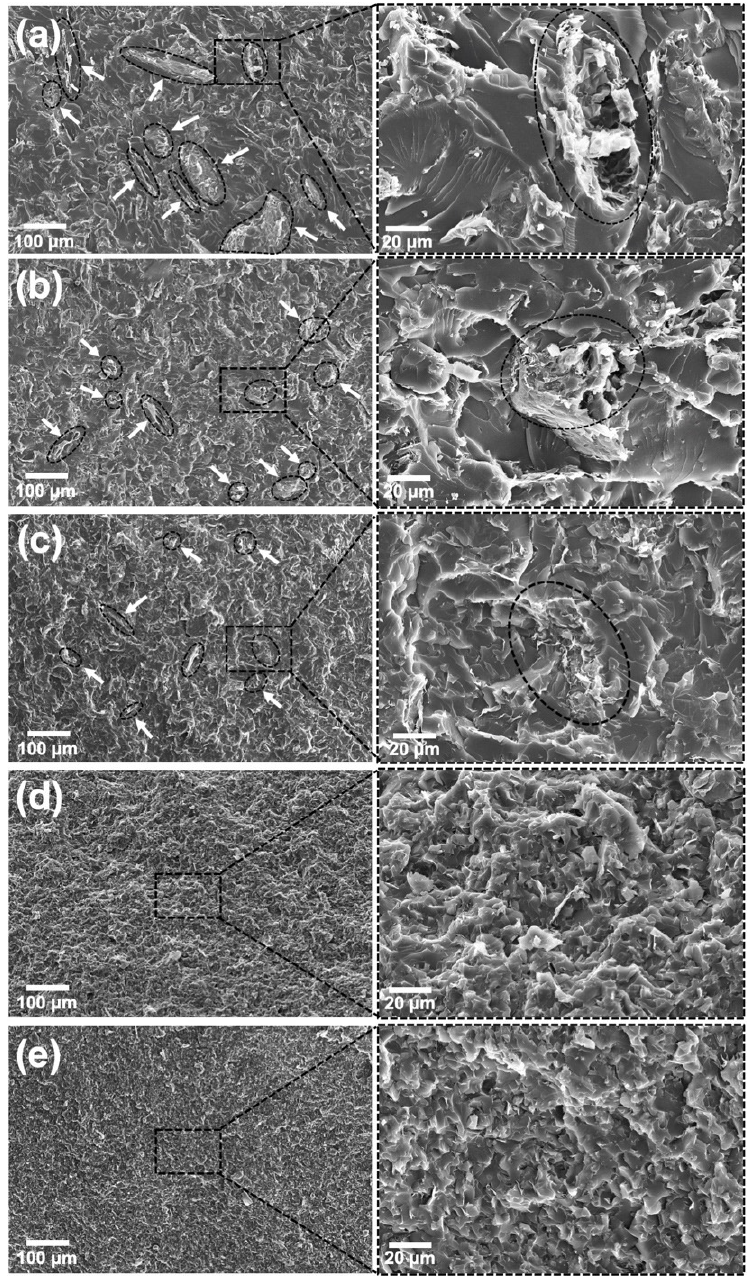
Figure 7. SEM images of GNP-filled nanocomposites at 2.5 wt.% loading, prepared without sonication ( a ); with indirect sonication for 120 min ( b ); and with direct sonication for 60 min at 25% amplitude ( c ), 50% amplitude ( d ) and 75% amplitude ( e ). GNP aggregates are highlighted.